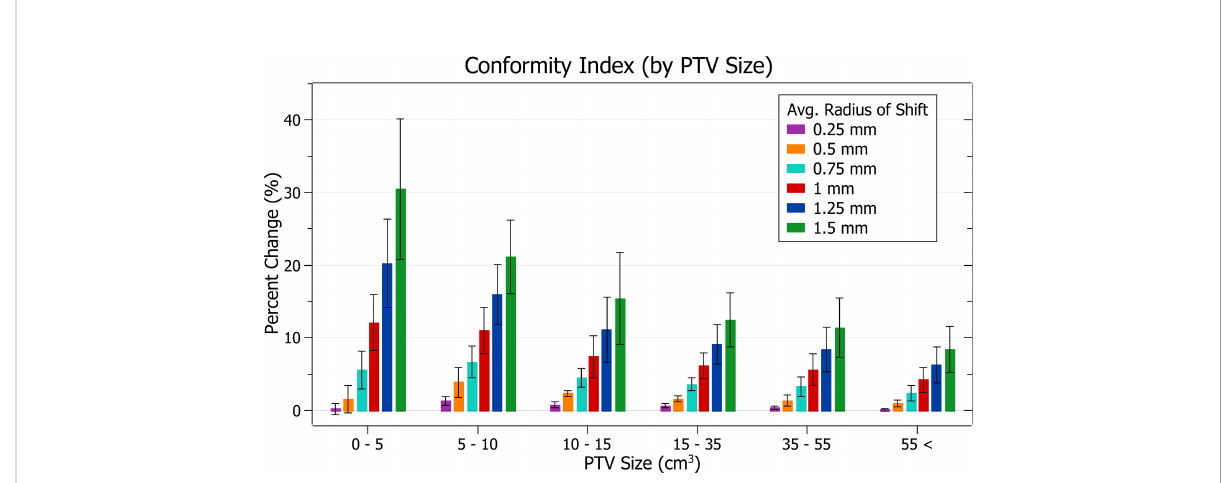
FIGURE 13 Average percentage change of conformity index for different radii of isocentre shift, categorised by PTV